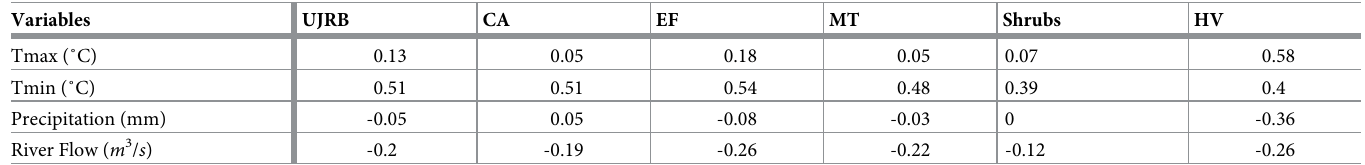
The greater spatial variability in NDVI trends across the UJRB are due to variation in responses of vegetation classes to climatic variables. Plant growth is influenced by changes in soil moisture and local water balance, which in turn are dependent on climatic variables (e.g., precipitation and temperature). This is reflected in the results in the form of greater spatial var- iability in correlations of annual and seasonal NDVI with precipitation across the UJRB (Figs 7 and 8). NDVI correlations with precipitation over the UJRB differ with vegetation classes. For Table 3. Annual correlation of NDVI of vegetation classes with precipitation (precip), maximum temperature (tmax) and minimum temperature (tmin) over the UJRB. Variables UJRB CA EF MT Shrubs HV Tmax (˚C) 0.13 0.05 0.18 0.58 Tmin (˚C) 0.51 Precipitation (mm) -0.05 River Flow ( m 3 / s ) A correlation coefficient of 0.3 corresponds to p < 0.05, 0.4 corresponds to p < 0.01 and 0.5 corresponds to p <